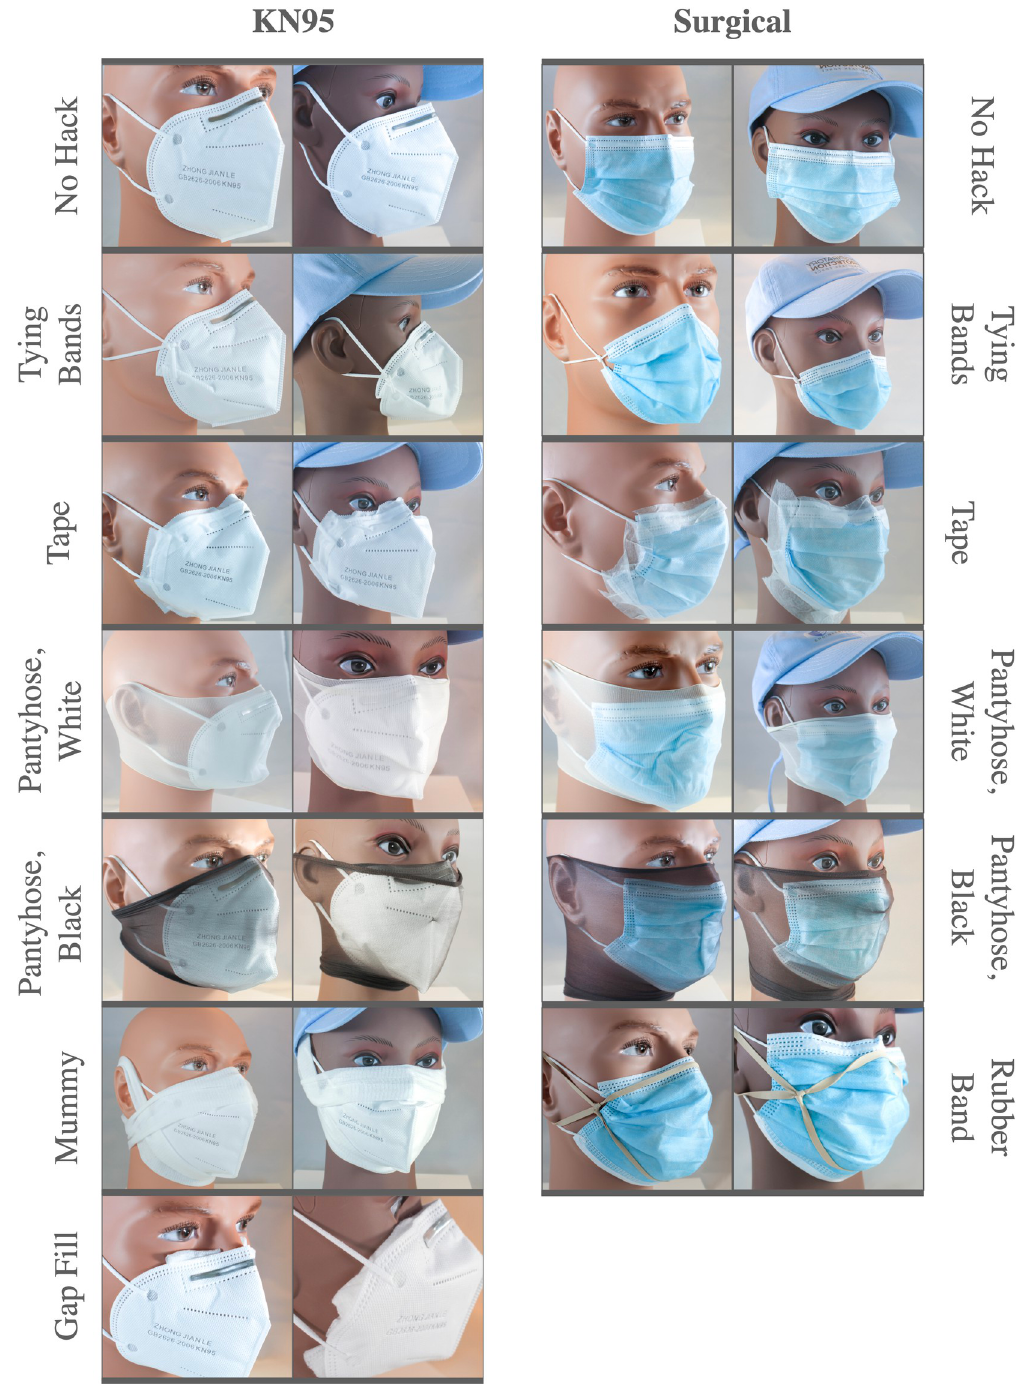
Fig 1. Pictures of the tested fit hacks applied to KN95 and surgical masks on two mannequin heads for display. The male mannequin head is the size of an average male, while the female represents the size of a small female head or young teen head.